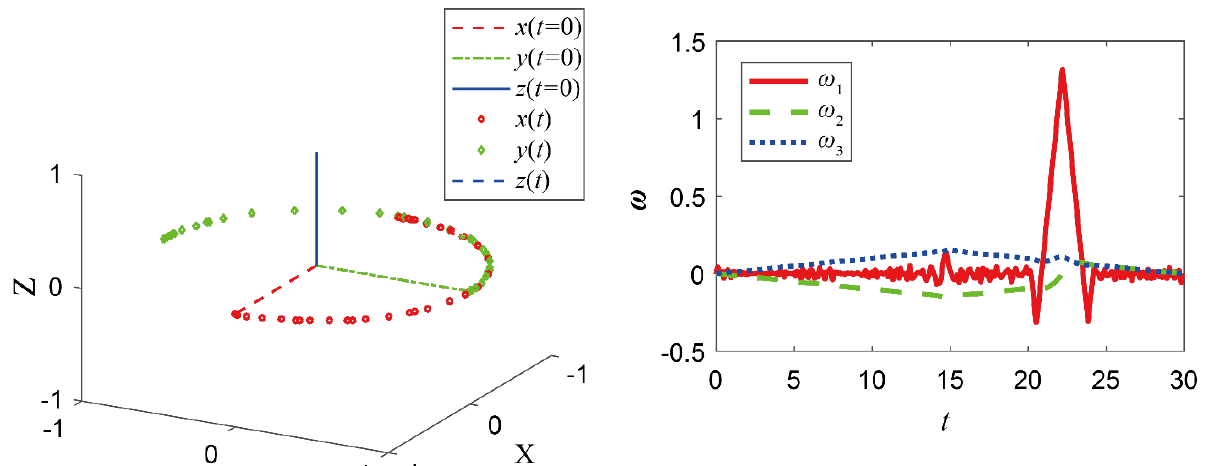
Figure 14. Nondimensional angular velocity histories for Case 17.